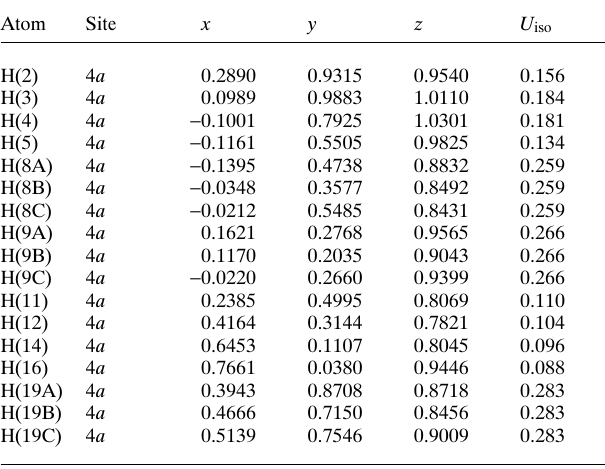
Table 2. Atomic coordinates and displacement parameters (in Å 2 ) . Atom Site x y z U